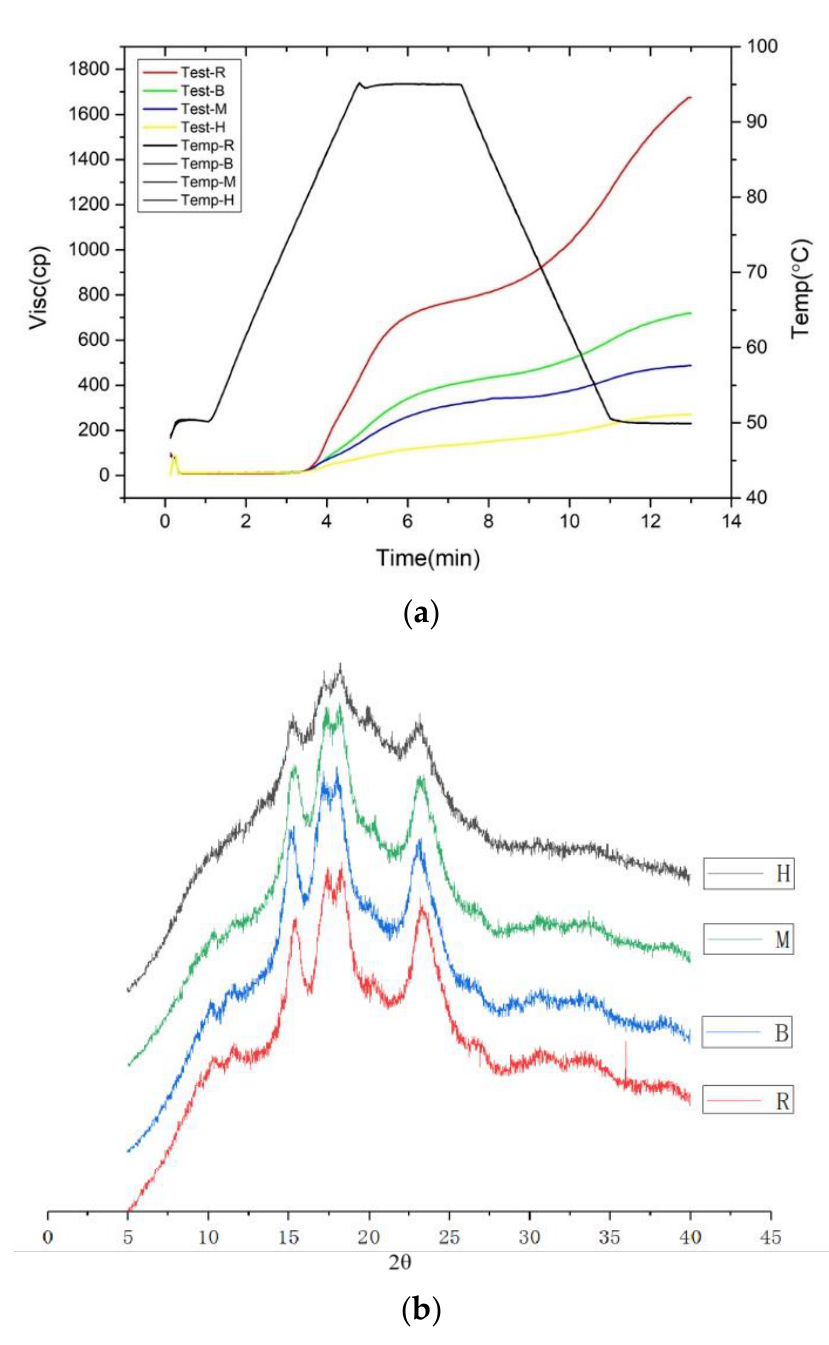
Figure 3. Physical-functional properties of roasted Euryale ferox seed (EFS) flour. ( a ) Viscosity curve of the raw, ( b ) X-ray diffraction pattern, and thermal processing EFS flours. R: Raw; M: Microwave; B: Baking; H: Industrial infrared heating-assisted fluidized bed (IHFH).